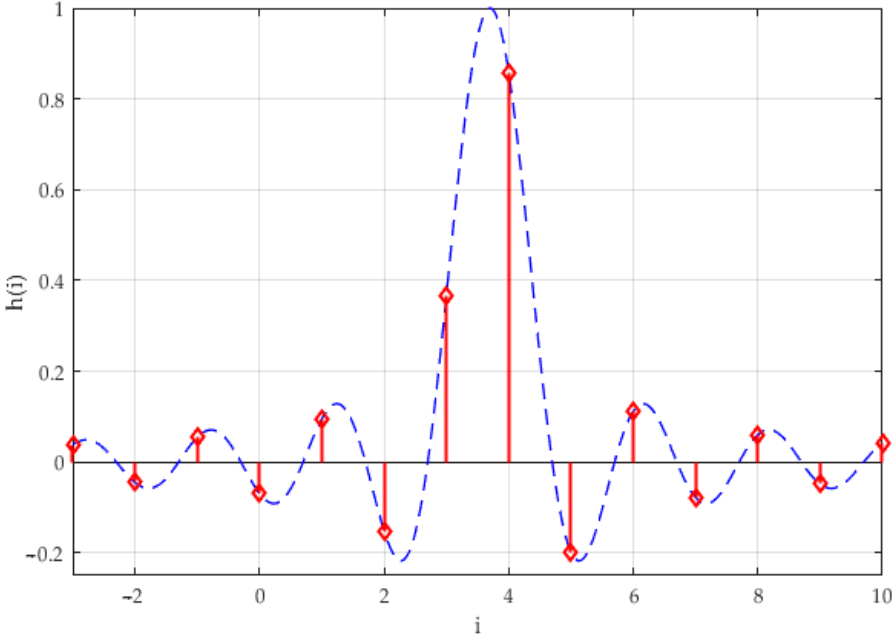
Figure 1. The impulse response of ideal fractional delay